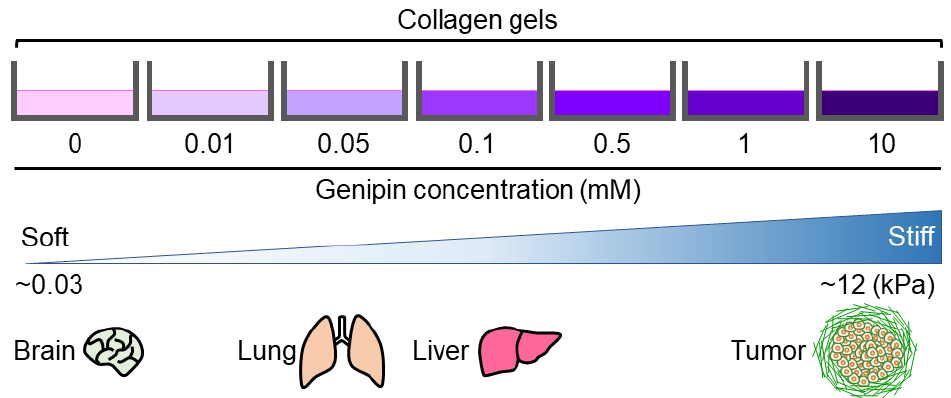
Figure 6. Stiffness-modulation of genipin-mixed collagen gels with the indicated genipin concentra- tions. The reported stiffness of brain, lung, liver, and tumor is also shown [6,9] . Previous studies have shown the potential of hydrogels as novel therapeutic agents.